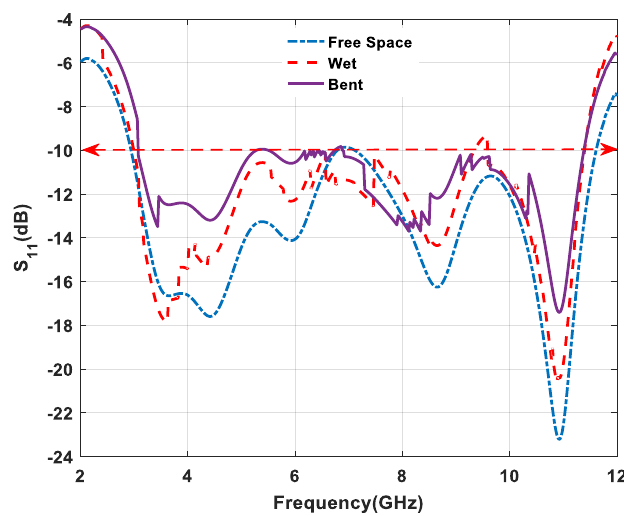
Figure 25. Measured return loss performance under various conditions.